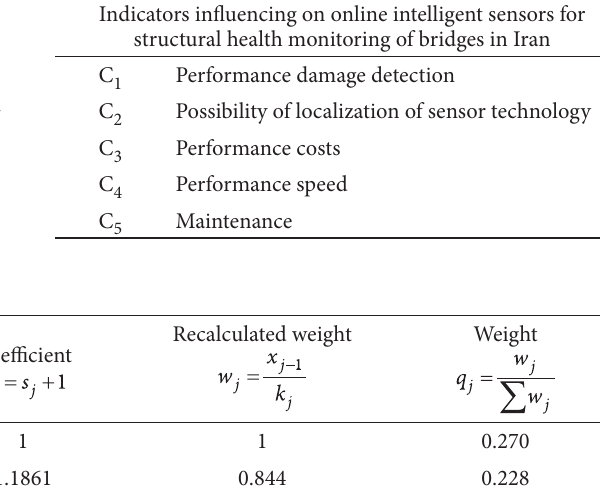
Table 2. Indicators influencing on online intelligent sensors for structural health monitoring of bridges in Iran